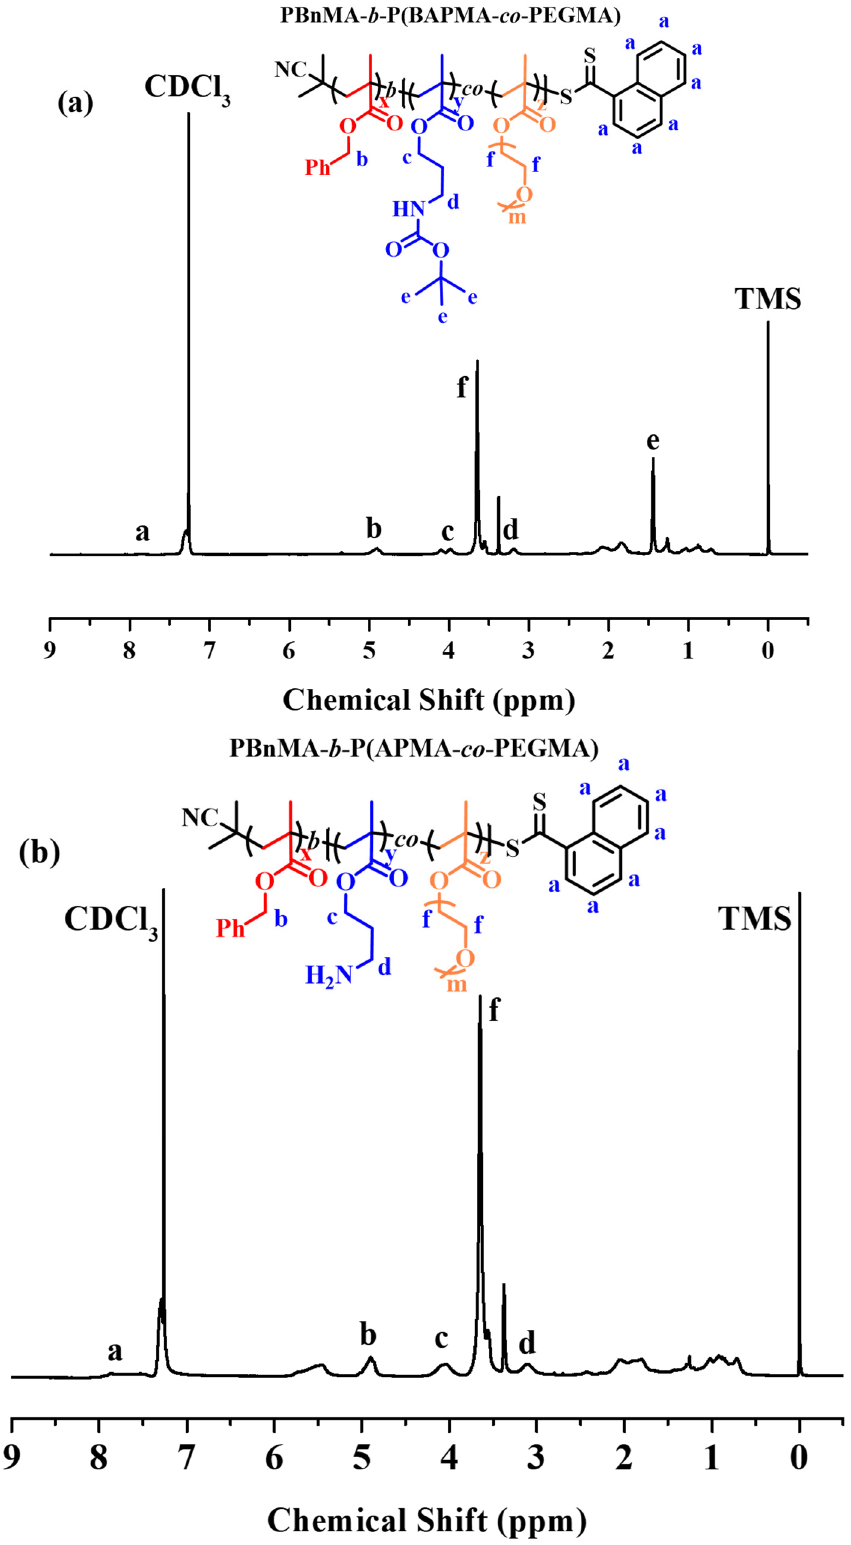
Figure 3. 1 H NMR spectra of ( a ) PBnMA- b -P(BAPMA- co -PEGMA) in CDCl 3 ; ( b ) PBnMA- b -P(APMA- co -PEGMA) in CDCl 3 .